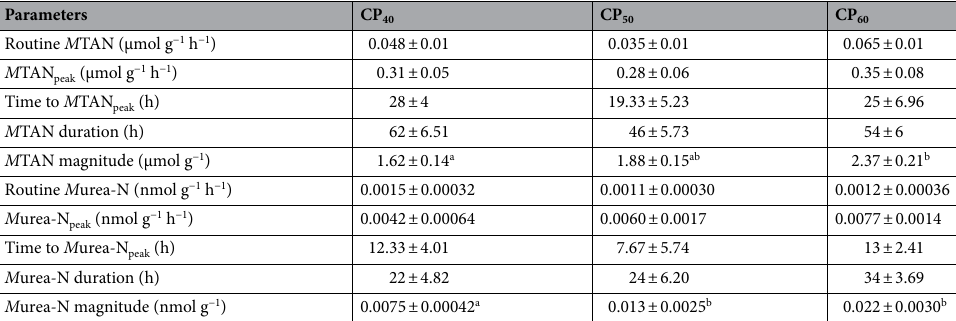
Table 2. Characteristics of total ammonia-N ( M TAN) and urea-N ( M urea-N) excretion in juvenile Sagmariasus verreauxi . Lobsters were reared at 21 °C and fed 15 N-labeled feeds at 1.5% body weight at three crude protein levels: 40%, 50% and 60%, corresponding to CP 40 , CP 50 and CP 60 treatments, respectively. M TAN peak , peak M TAN; M urea-N peak , peak M urea-N. All data represent mean ± standard error (SE) of 6 individuals. Different superscripts (a, b) in each row indicate significant differences among treatments (One- way ANOVA, P <